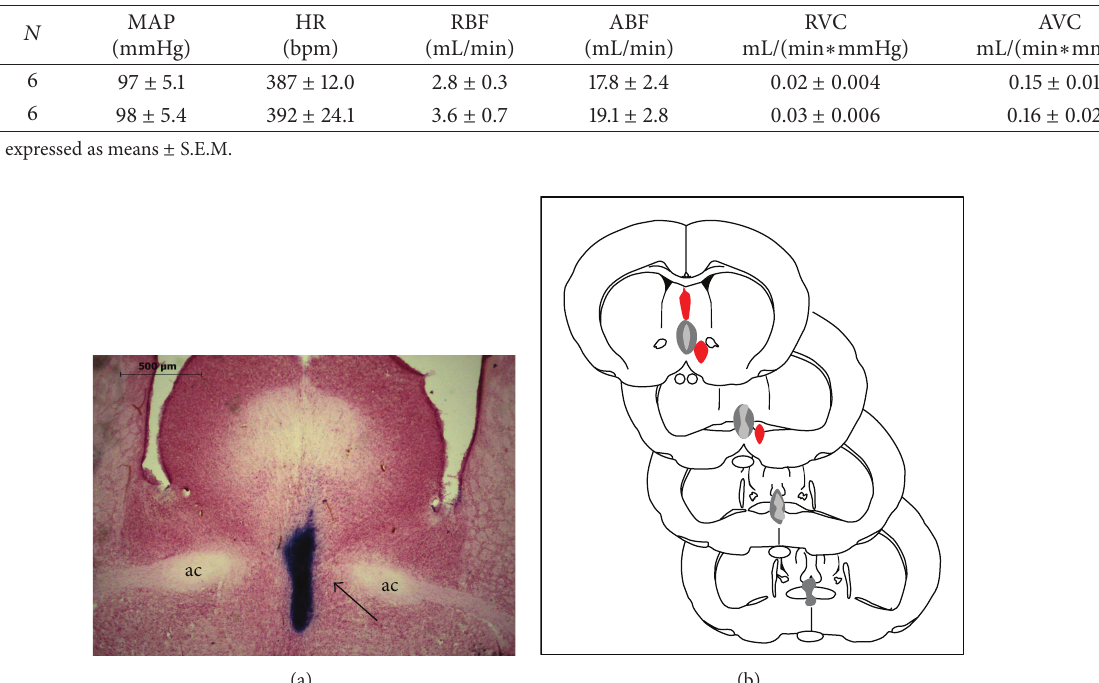
Table 1: Baseline values of mean arterial pressure (MAP), heart rate (HR), renal blood flow (RBF), aortic blood flow (ABF), renal vascular conductance (RVC), and aortic vascular conductance (AVC) in the control (CONT) and experimental (EXP) groups.